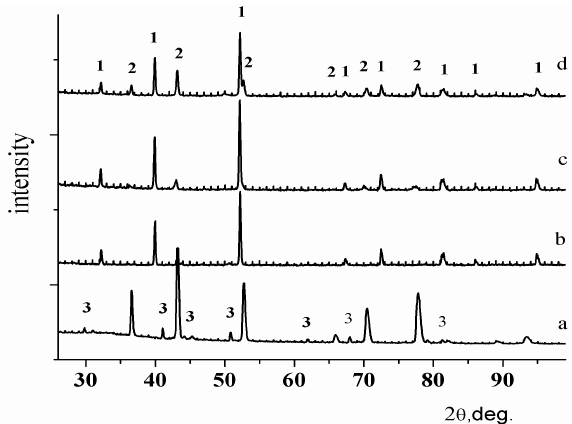
Figure 4. X-ray diffraction patterns of TiB 2 composites with different contents of alumina-magnesia spinel: ( a ) MgAl 2 O 4 ; ( b ) TiB 2 + 10% MgAl 2 O 4 ; ( c ) TiB 2 + 25% MgAl 2 O 4 ; ( d ) TiB 2 + 40% MgAl 2 O 4 . 1-TiB 2 , 2-MgAl 2 O 4 , 3-Al 2 O 3 .